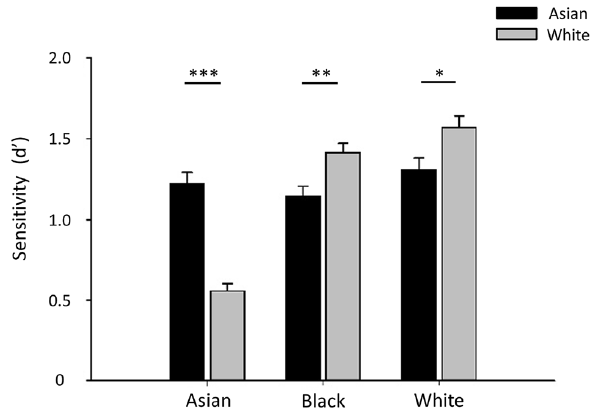
Figure 1. Performance (d’) on the matching task with Asian and White participants viewing Asian, Black and White faces. The data show a clear ORE with higher performance on own-race compared to other-race faces. Error bars show + 1 SEM. *** p < 0.001, ** p < 0.01, * p <